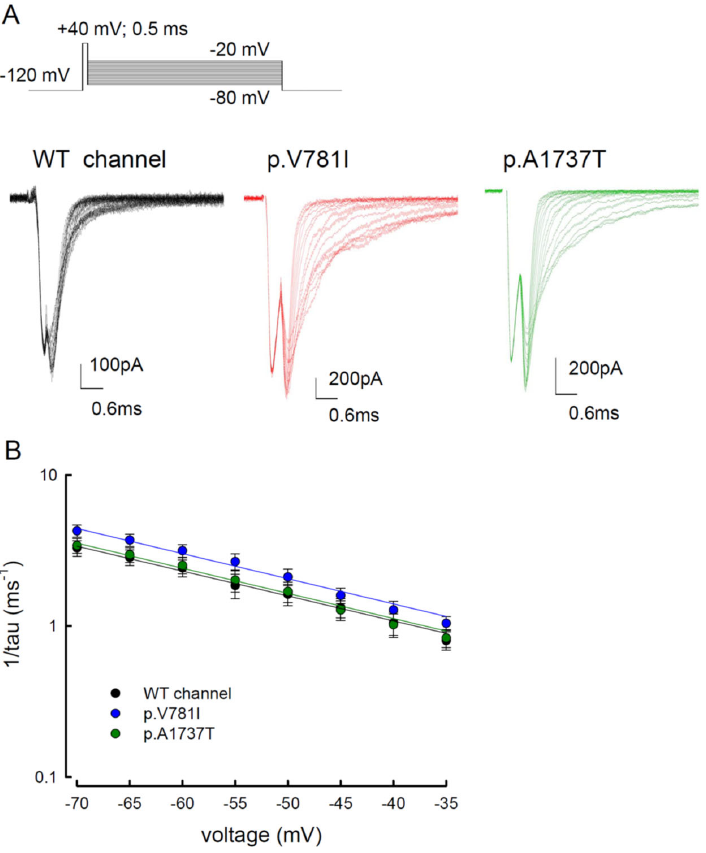
Figure 8. The tail current protocol was used to estimate the steady ‐ state activation curve for the WT, p.V781I, and p.A1737T mutant channels. ( A ) The cells were held at − 120 mV and depolarized